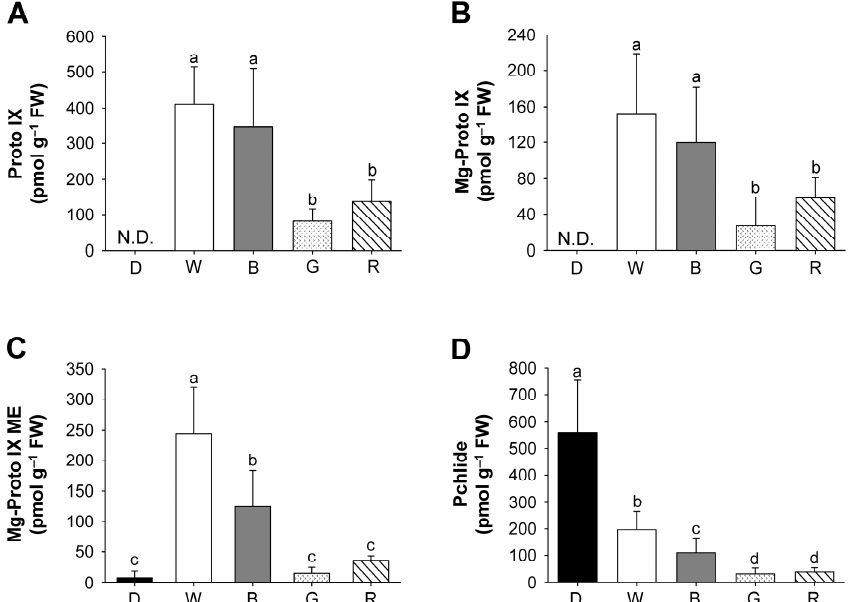
Figure 4. Effects of different wavelengths of LEDs on the distribution of porphyrin intermediates. ( A ) Proto IX; ( B ) Mg-Proto IX; ( C ) Mg-Proto IX ME; and ( D ) Pchlide. The plants were subjected to the same treatments as in Figure 2, and treatment notations are the same as in Figure 2. N.D., not detected. The data represent the mean ± SD ( n = 6–8). Means denoted by the same letter did not differ significantly at p < 0.05 according to Duncan’s multiple range test.